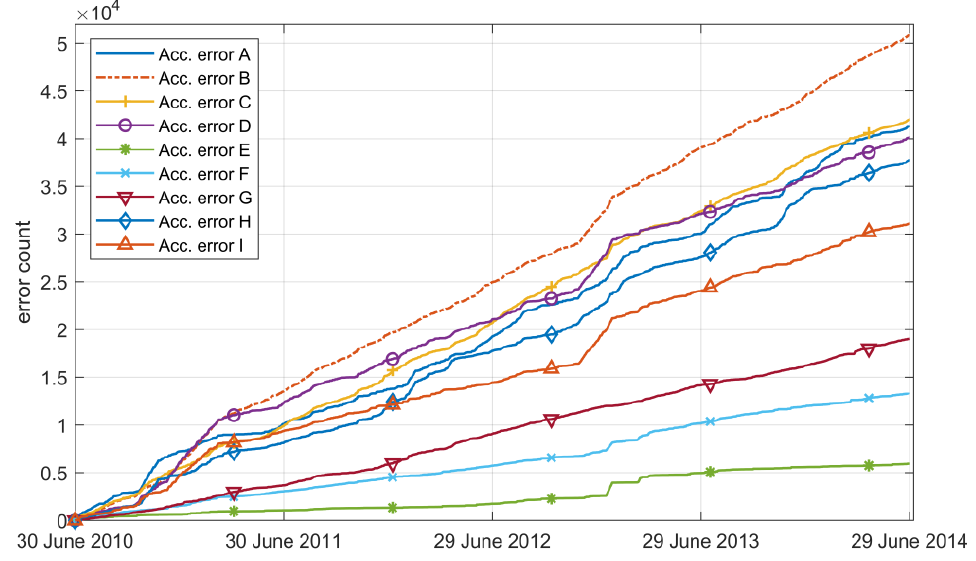
Figure 12. One-year accumulated alarms for each agent.